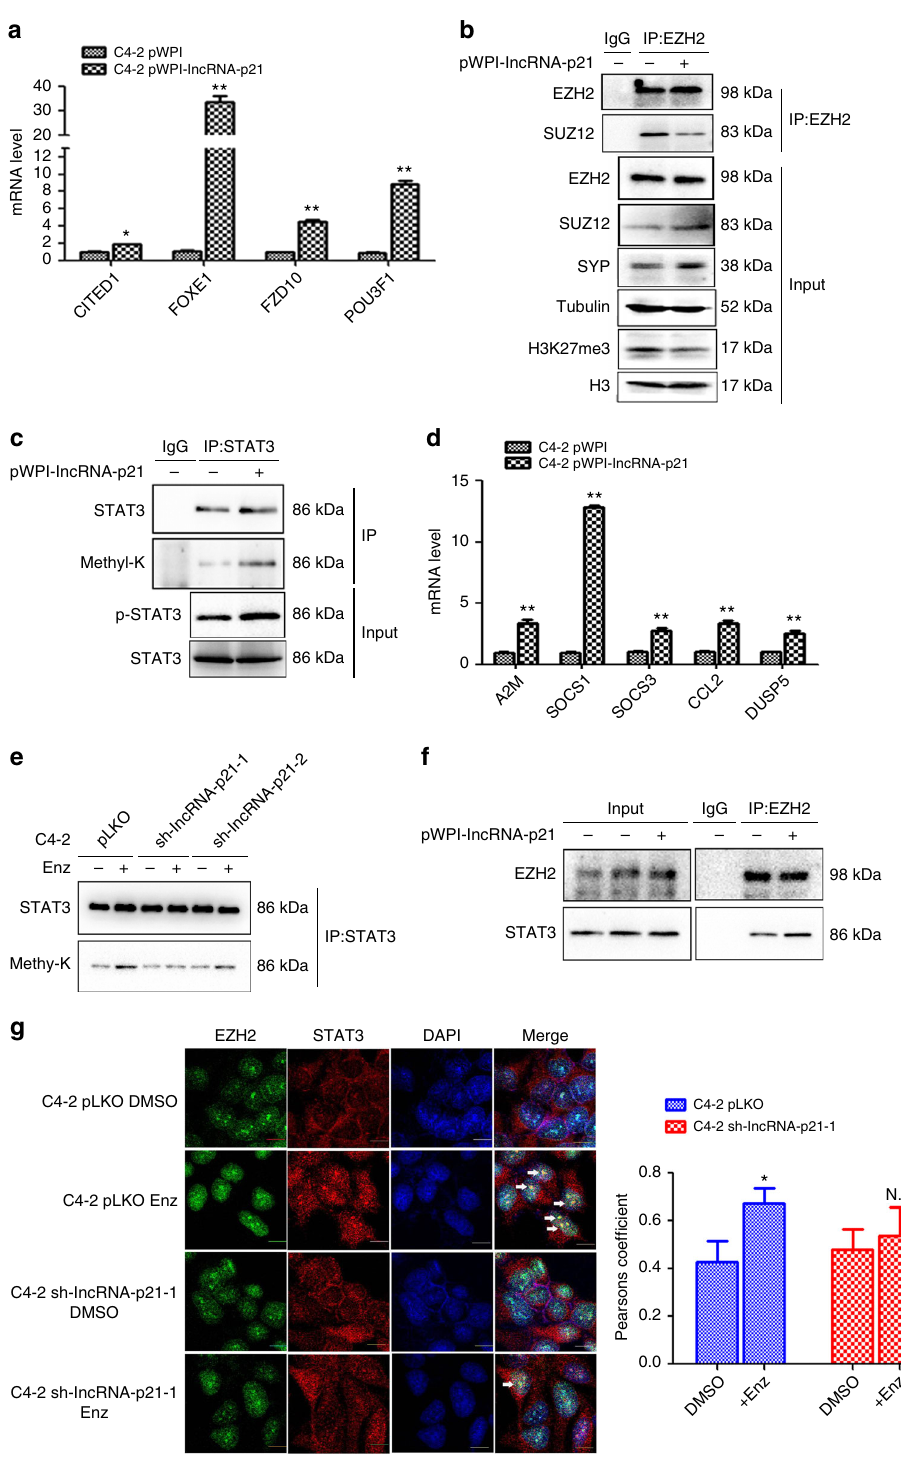
Fig. 5 The lncRNA-p21 disrupts the PRC2 complex and promotes EZH2 to methylate STAT3. a The qPCR analysis of PRC2 target gene expressions in C4-2 cells after overexpression of lncRNA-p21. b EZH2 protein was immunoprecipitated in C4-2 pWPI and pWPI-lncRNA-p21 cells. The co-immunoprecipitated SUZ12 levels were detected by WB. The SYP and H3K27Me3 levels in input samples were also detected by WB. c The WB analysis of STAT3 methylation and phosphorylation with/without (w/o) overexpression of lncRNA-p21 in C4-2 cells. d The qPCR analysis of STAT3 target genes expressions in C4-2 cells w/o overexpression of lncRNA-p21. e The lncRNA-p21 knockdown can reduce Enz-induced STAT3 methylation. C4-2 pLKO and 2 different sh-lncRNA-p21 transfected cells were treated w/o Enz for 4 days. The STAT3 methylation was detected by WB. f Co-IP assay to detect the interaction between EZH2 and STAT3 w/o overexpression of lncRNA-p21 in C4-2 cells. g Confocal microscopic images of co-localization of EZH2 and STAT3 w/o Enz treatment in C4-2 pLKO and sh-lncRNA-p21 cells. The co-localization of EZH2 and STAT3 was analyzed by Pearsons coef fi cient (Scale bar = 2 μ m). Quantitation on the right. For a , d , g , data are presented as mean ± SD, * p < 0.05, ** p < 0.005, N.S. not signi fi cant by t-